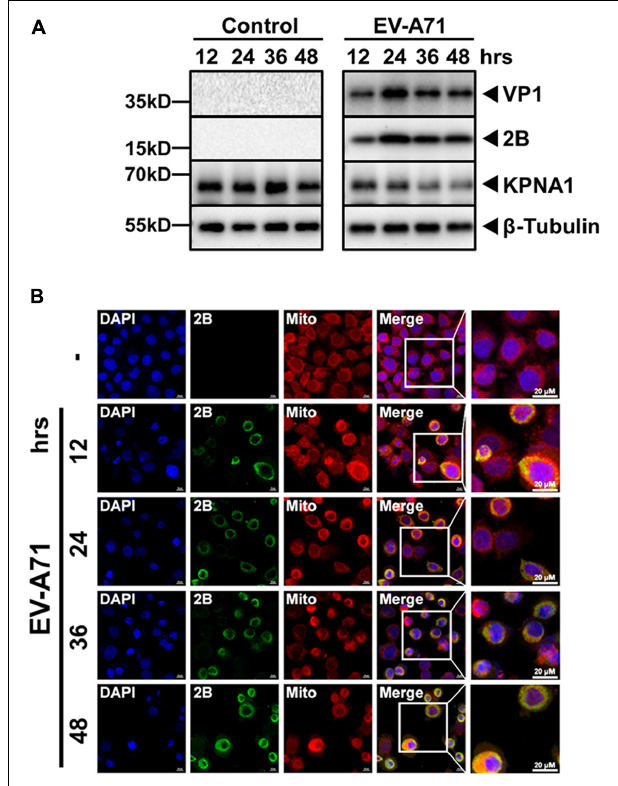
FIGURE 7 | Expression and localization of viral 2B protein in EV-A71 infected cells. HeLa cells were infected with EV-A71 at an MOI of 1. Cell lysates were prepared at indicated time points p.i for western blot analyses with antibodies for VP1, 2B, KPNA1 or β -Tubulin (A) . The cells, infected or non-infected, were fixed at indicated time points p.i. and subjected to confocal immunofluorescence imaging with antibodies for viral 2B (B) . Cell nuclei were stained with DAPI and the mitochondria were stained with MitoTrackerTM Deep Red FM. Magnification, ×